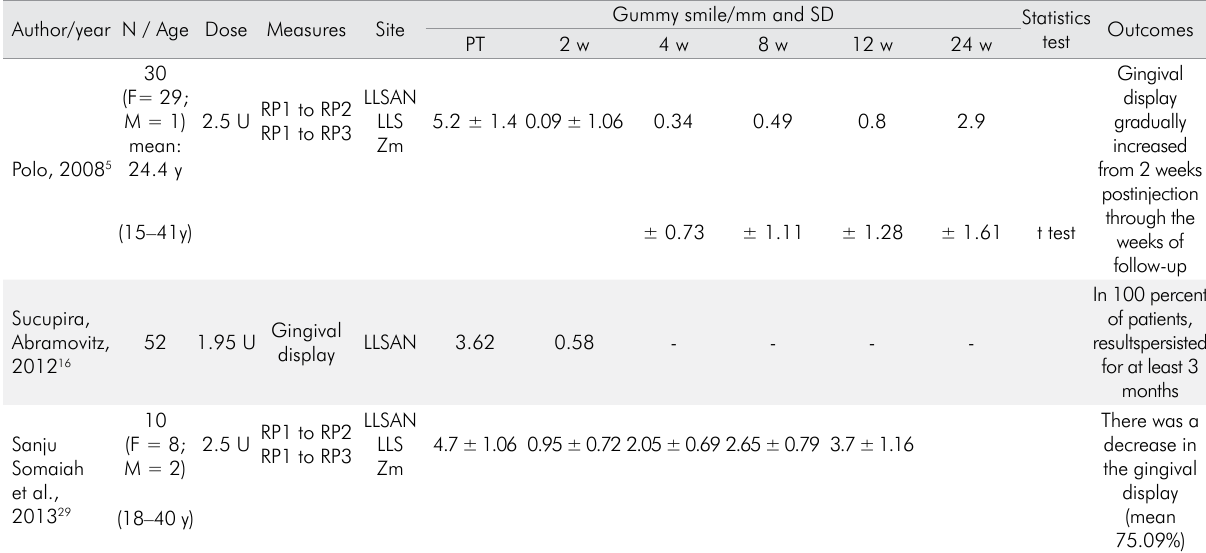
Table 2. Data from the studies included.